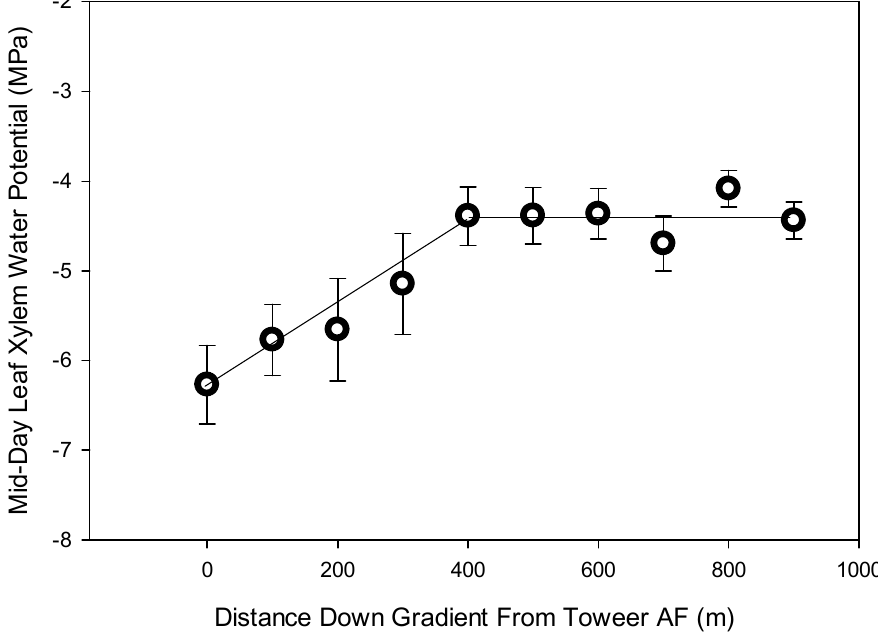
Figure 5. Creosote leaf xylem water potential with error bars measured at mid-day along the 900 m gradient starting at tower AF during June–October 2016. Canopy minus ambient temperatures (delta T) of creosote taken at mid-day during summer and winter varied along the 900 m gradient but were not statistically different ( − 1.82 summer vs. − 1.88 winter. p = 0.48). During the summer of 2015 only 3 of the 10 delta T values were positive while during the winter only 2 of the 10 values were positive. However, 4 of the 5 positive values occurred at either the zero location (Tower AF) or at 100 m from Tower AF, with the highest delta T value approaching 2 ◦ C. The fact that 15 of the 20 delta T values were negative during summer and winter suggested that creosote was able to maintain low delta T values through evaporative cooling via